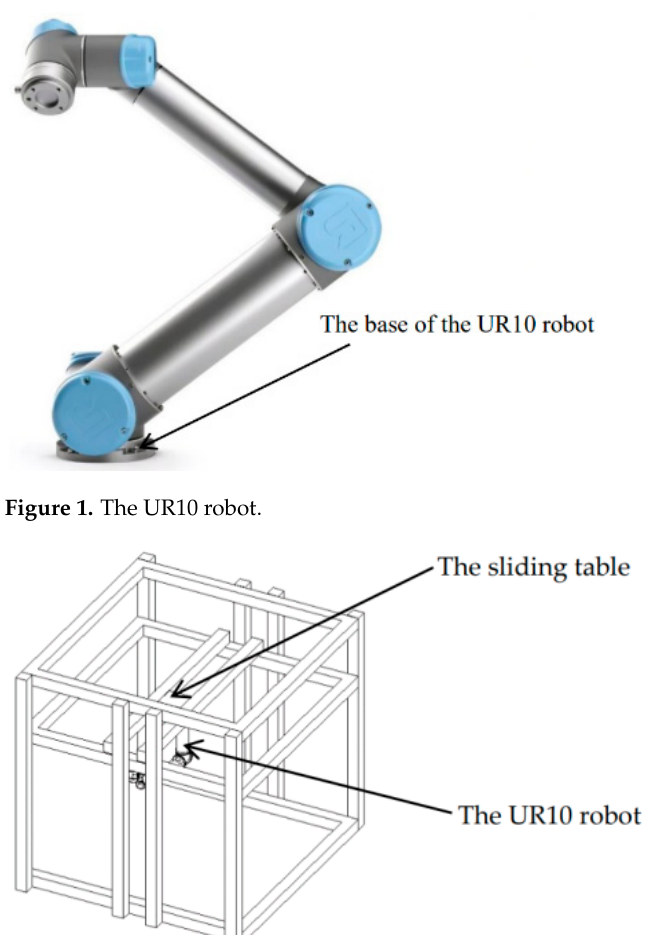
Figure 2. The upside-down installation of the UR10 robot.